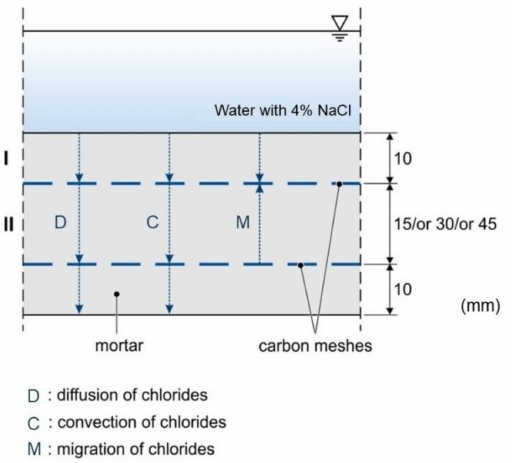
Figure 2. Schematic picture of the investigated structure and ion